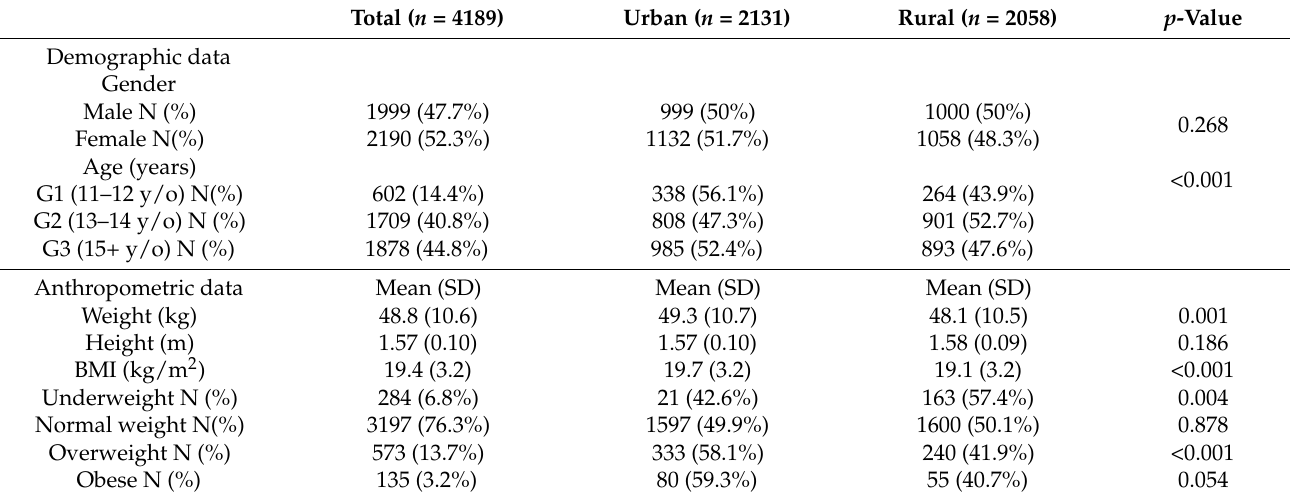
Table 1. Descriptive statistics of the study population according to location (urban/rural).